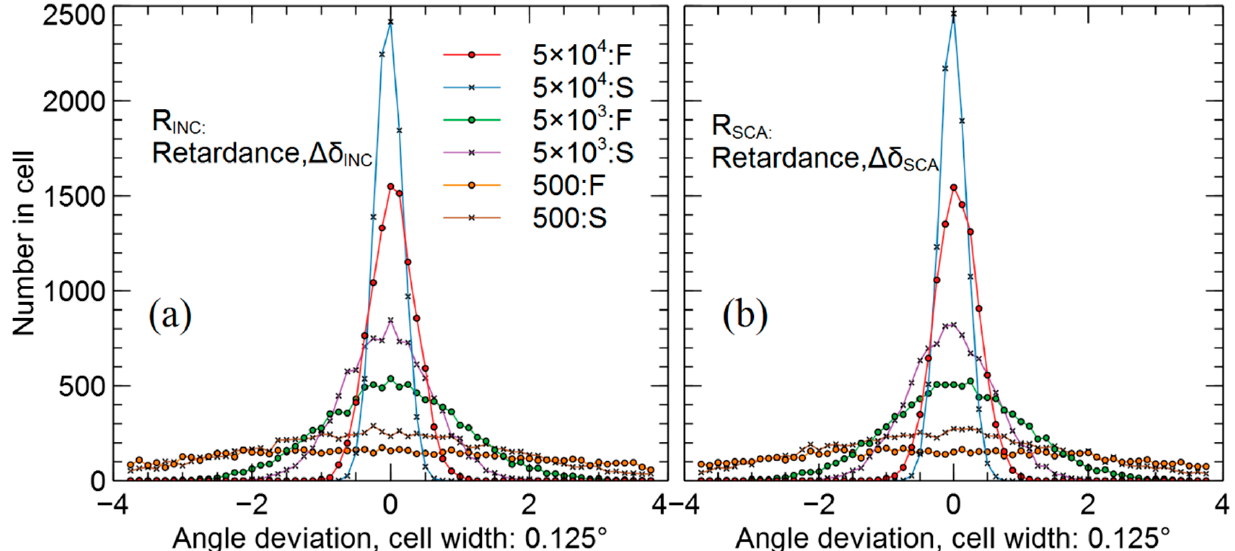
  > > Δ ( a ) and δ Δ ( b ) of δ INC ( a ) and ∆ δ SCA ( b ) of the SCA